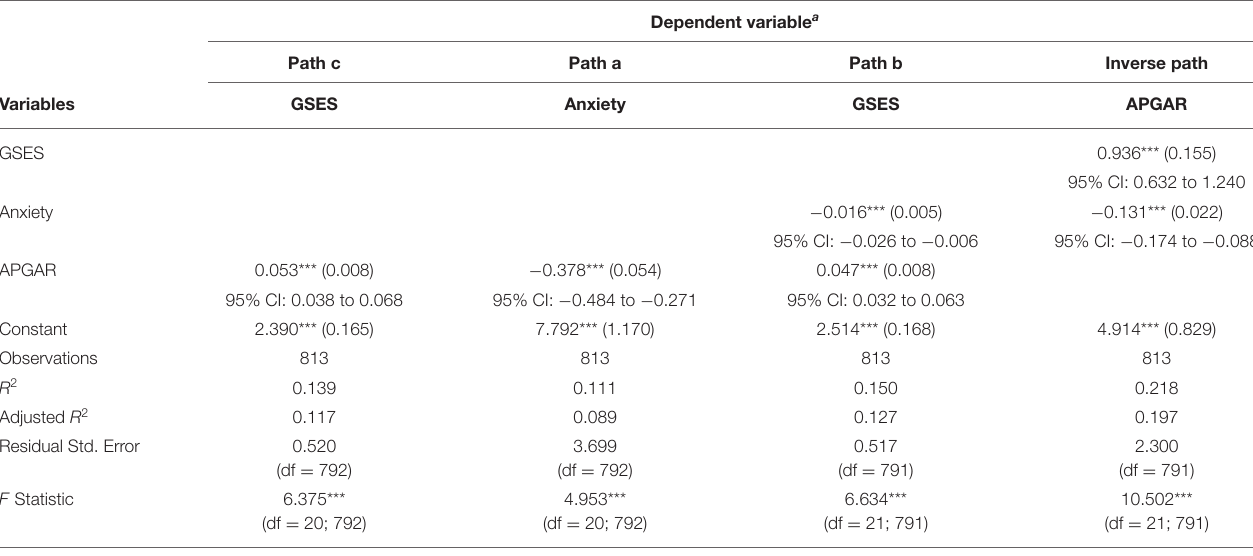
TABLE 4 | Mediation model showing role of anxiety symptom on relationship between family function and self-efficacy, β (SE), and 95% CI for β